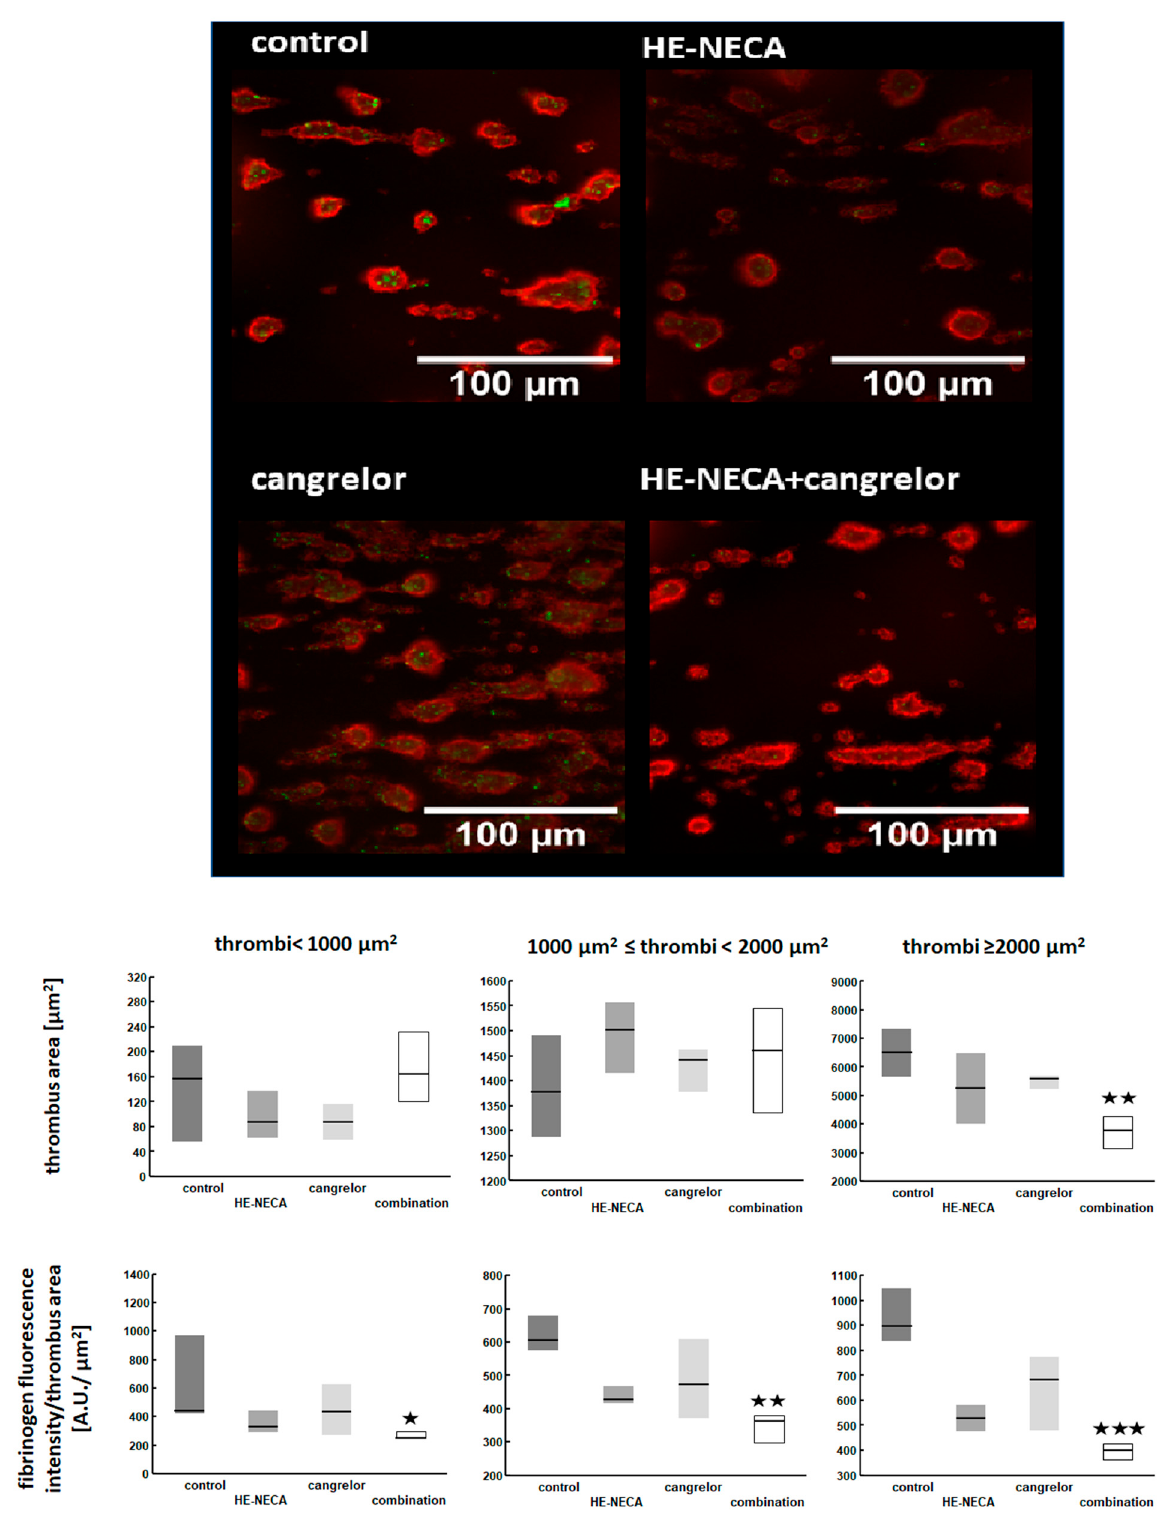
Figure 4. Effects of cangrelor and HE-NECA applied alone or in a combination on thrombi formed in vitro under flow conditions. Representative images show thrombi (red) formed under flow conditions and fibrinogen deposits (green). Area of individual thrombi and fibrinogen deposition in these thrombi presented as median with IQR, n = 6, statistical significance was tested with Friedman’s test followed by the Dunn’s multiple comparison test (only relevant comparisons were tested). * p < 0.05 (corrected), ** p < 0.01 (corrected), *** p < 0.001 (corrected).